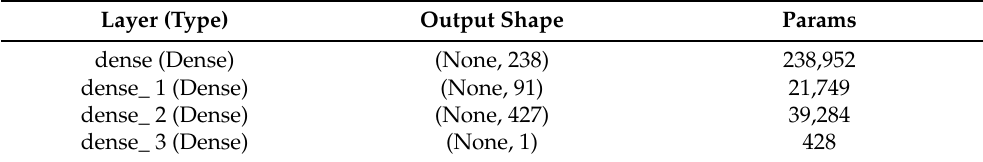
Table 5. Total parameters of the DNN: 300,413. All the parameters are considered